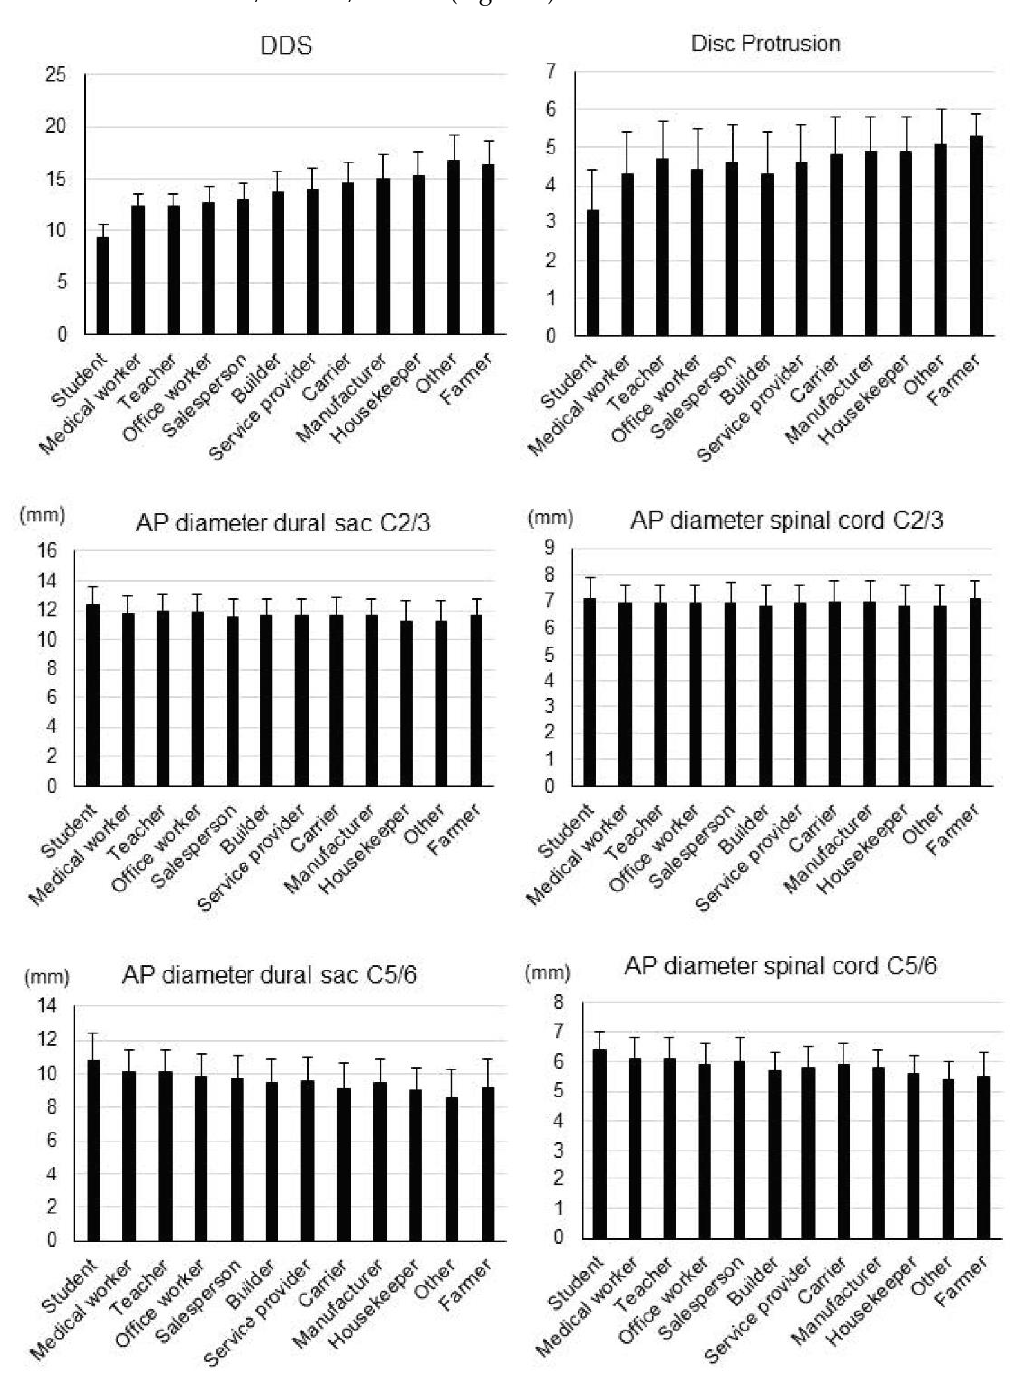
Figure 2. Disc degeneration data. Overall disc degeneration score (DDS), number of disc protrusions, and anteroposterior (AP) diameters of the dural sac and spinal cord at the C2/3 and C5/6 levels in each occupation group. Occupations are listed in ascending order of age.